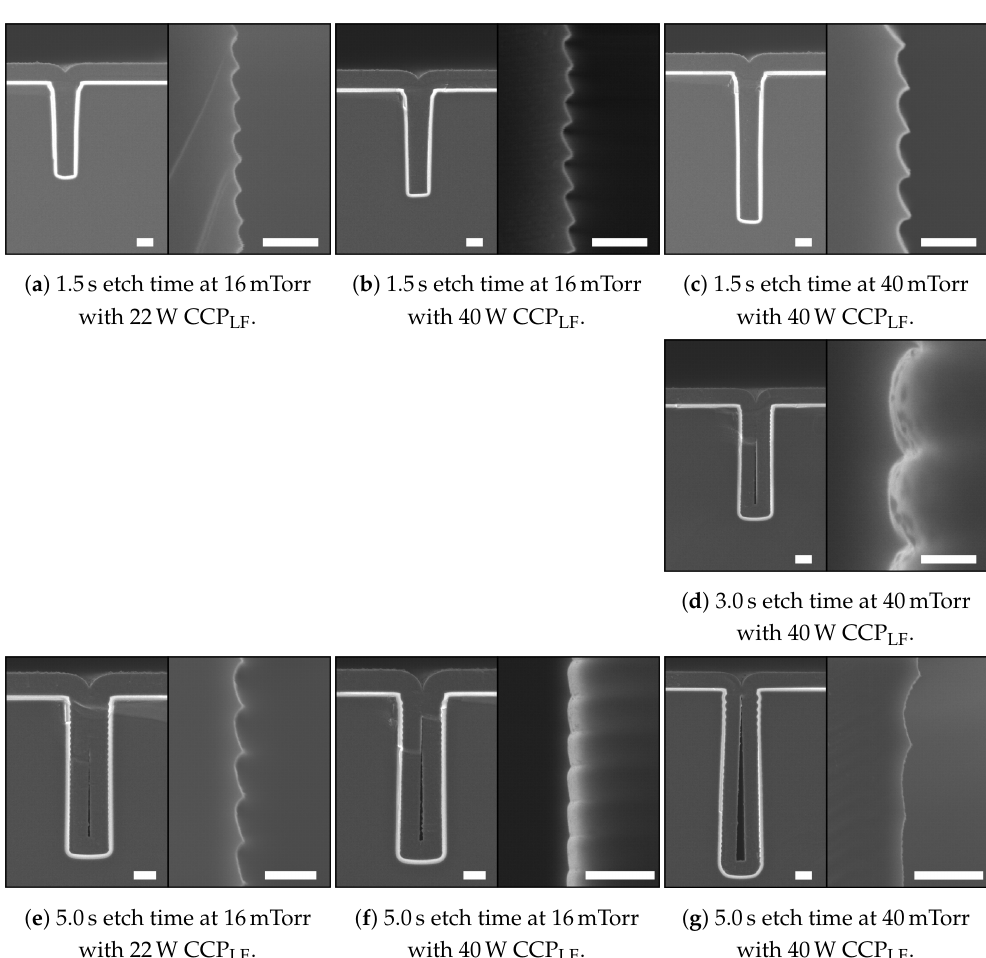
Figure 16. An overview of SEM images showing the relation of scallop dimensions on the refill of the trench. Each picture shows on the left side the complete trench, etched with different etch cycle settings and refilled with the multi-layer stack of 400nm t-SiO 2 and 2µm poly-Si, and on the right side a close-up image of the scallops prior to the refill. These scallops were also used to construct the graphs of Figures 13–15. The scale bars in ( a – d ) are 2µm and 200nm for the left and right figures, respectively. The scale bars in ( e ) are 2µm and 500nm for the left and right figures, respectively. The scale bars in ( f , g ) are 2 and 1µm for the left and right figures, respectively. To demonstrate the wafer-scale uniformity of this method, a 5-point (centre, north, east, south, and west) cross-sectional SEM inspection with a 1 cm edge exclusion was performed on the wafer etched with the settings in Table 3, with etch-cycle time ( A ) being 1.5 s, etch platen power ( B ) being 40 W, and process pressure ( C ) being 40 mTorr. The results of this inspection are shown in Figure